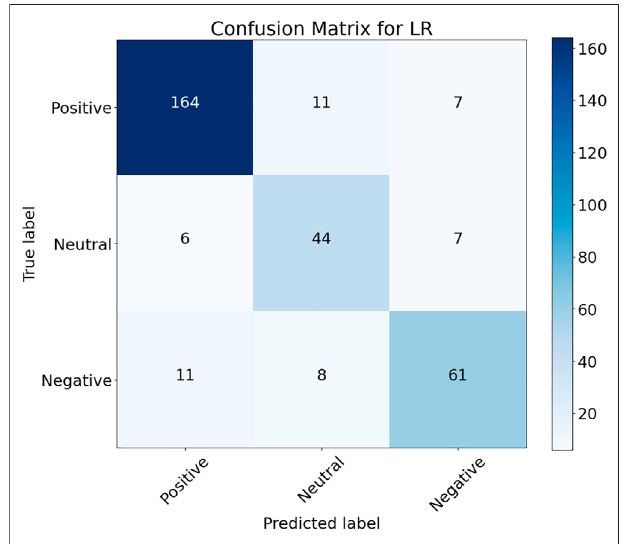
FIGURE 6 | LR performance on test data